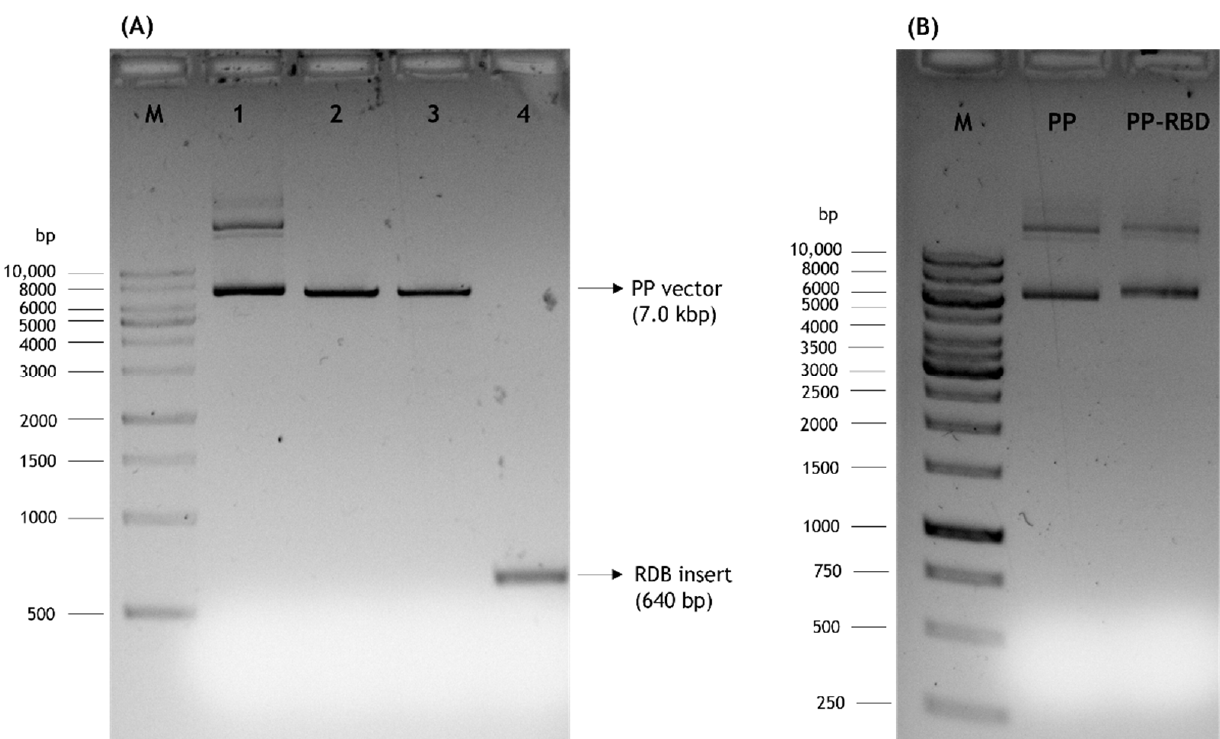
Figure 3. Analysis of DNA fragments by agarose gel electrophoresis. M–molecular weight marker. ( A ) 1–PP vector; 2–PP vector digested with XbaI; 3–PP vector digested with XbaI and BamHI; 4–RBD insert digested with XbaI and BamHI. ( B ) Initial PP and PP-RBD vector.